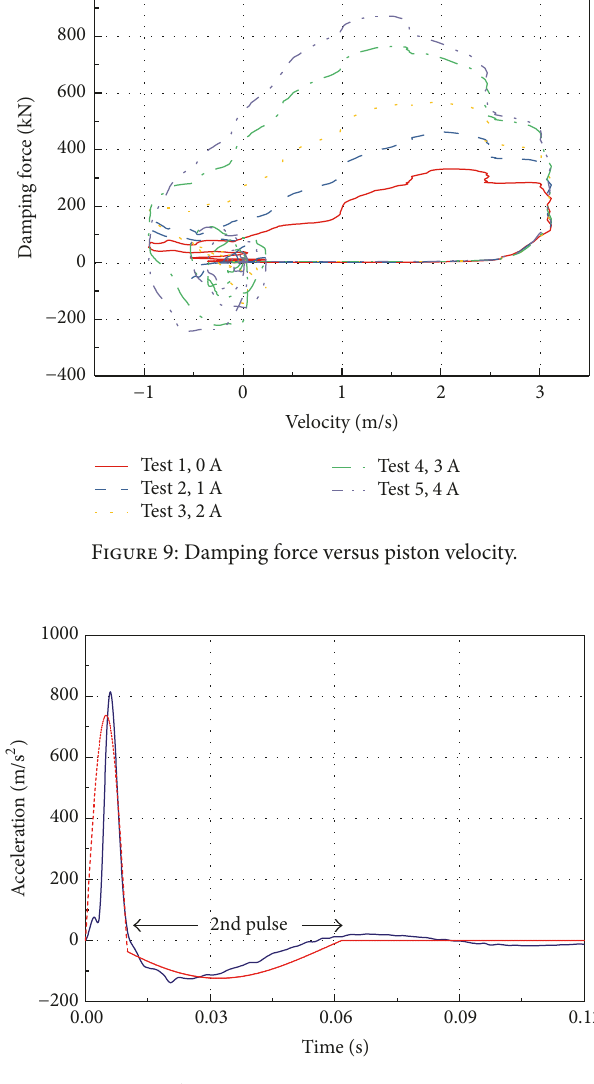
Figure 12: Comparison test and simulation results (Test #3: 2